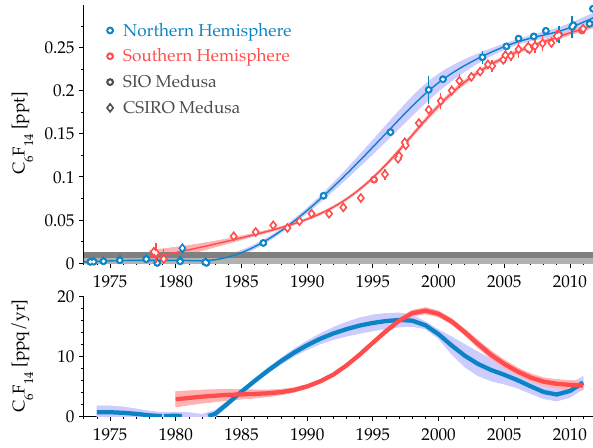
Fig. 1. The top panel shows the atmospheric mole fractions of C 4 F 10 based on Northern Hemisphere (blue circles and diamonds) and Southern Hemisphere (red circles and diamonds) archived air sample measurements. The circles are for the samples measured on the SIO Medusa and the diamonds are for the samples measured on the CSIRO Medusa. The vertical bars on the observations denote the 1- σ standard deviations of the sample measurements (often the measurement uncertainty is too small to be seen on the figure). The blue and red lines are the best fits to the Northern Hemisphere and Southern Hemisphere observations, respectively, and the shading is their estimated uncertainties. The grey shading shows the detec- tion limits for the two Medusa systems, with light grey for the SIO Medusa and dark grey for the CSIRO Medusa. The bottom panel shows the average annual growth rates in mole fractions for the Northern (blue) and Southern (red) Hemispheres, calculated from the smoothing spline fits, and their estimated uncertainties, shown as the shading.